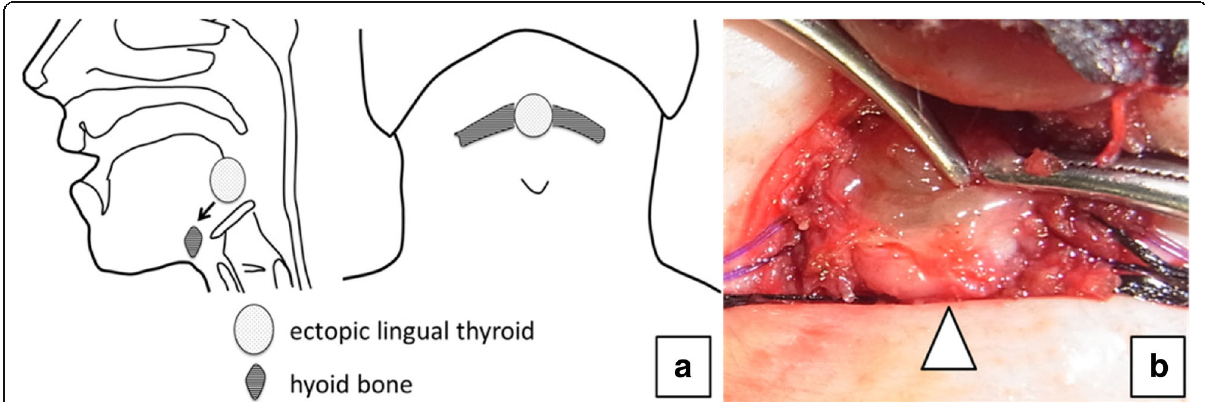
Fig. 2 Mass suspension procedure for lingual ectopic thyroid. Schema of mass suspension procedure ( a ). We suspended the mass (arrow head) by suturing it to the hyoid bone ( b )